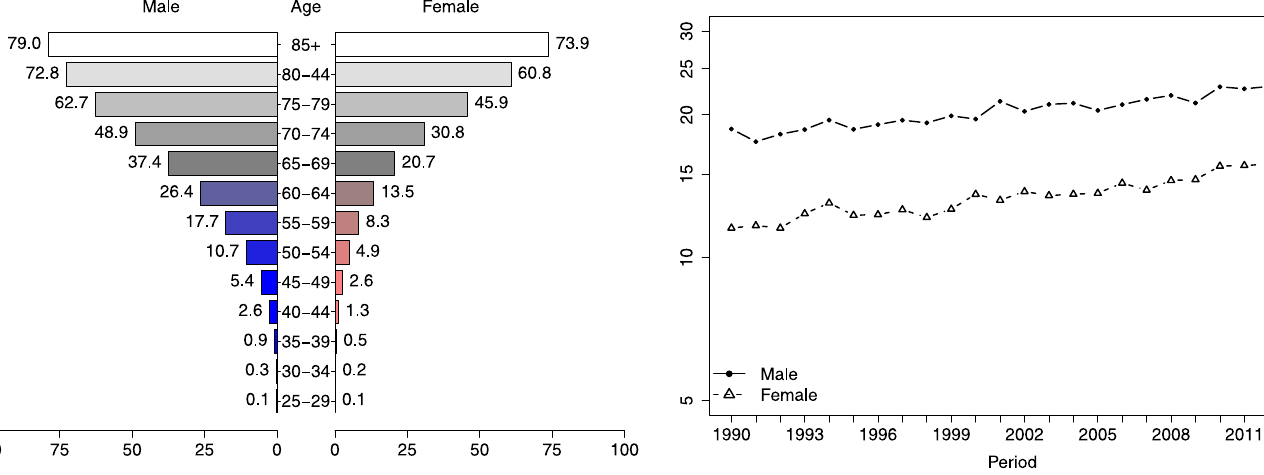
cohort as well as space-cohort and space-time interactions were considered. Model fitting and inference were carried out using Bayesian methodology, specifically, integrated nested Laplace approximations (INLA) (see [10]). The technique is implemented in the software R through the package R-INLA (www.r-inla.org). Finally, to select the best model among the different proposals, the WAIC [11] and the DIC information criteria [12] were computed. In what fol- lows a detailed description of the final selected model is provided. Conditional on the mortality rate r , the number of deaths C is assumed to be conditionally independent Poisson dis- gait gait tributed, i.e.